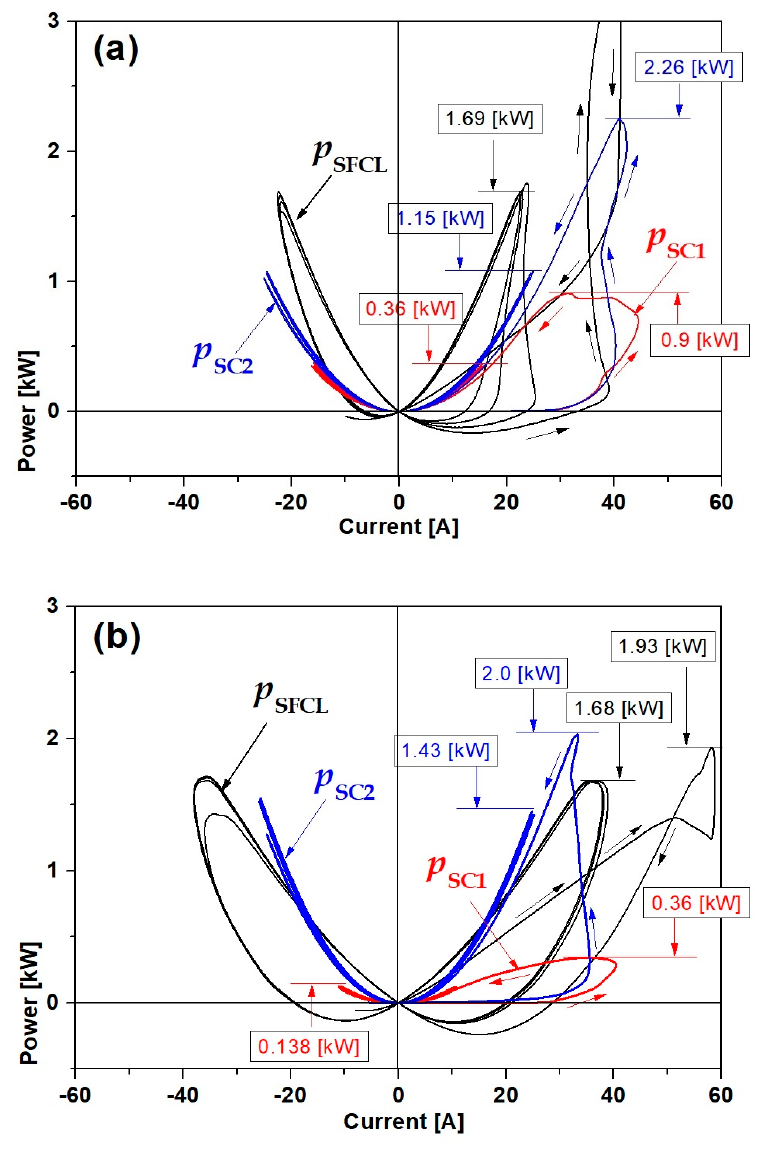
Figure 6. Instantaneous power curves for currents of the SFCL and two superconducting elements during the fault cycle according to the winding direction: ( a ) the reverse winding direction ( b ) the same winding direction.